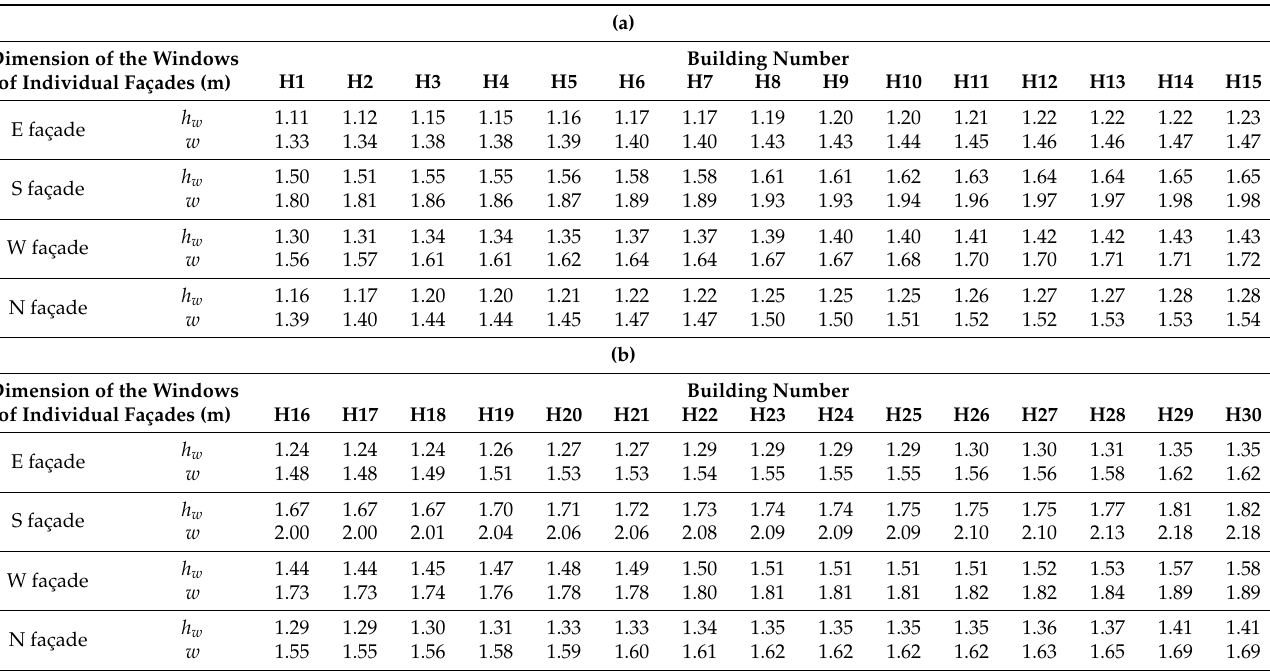
Table 4. ( a ) Dimensions of the windows on the individual façades of buildings H1–H15. ( b ) Dimen- sions of the windows on the individual façades of buildings